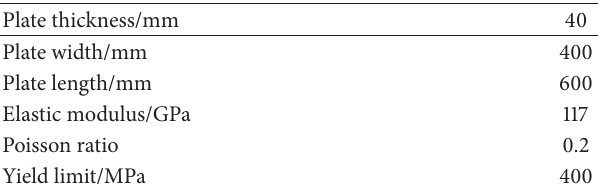
Figure 4: The cloud chart of the effective plastic strain. Table 1: Basic information about plate.